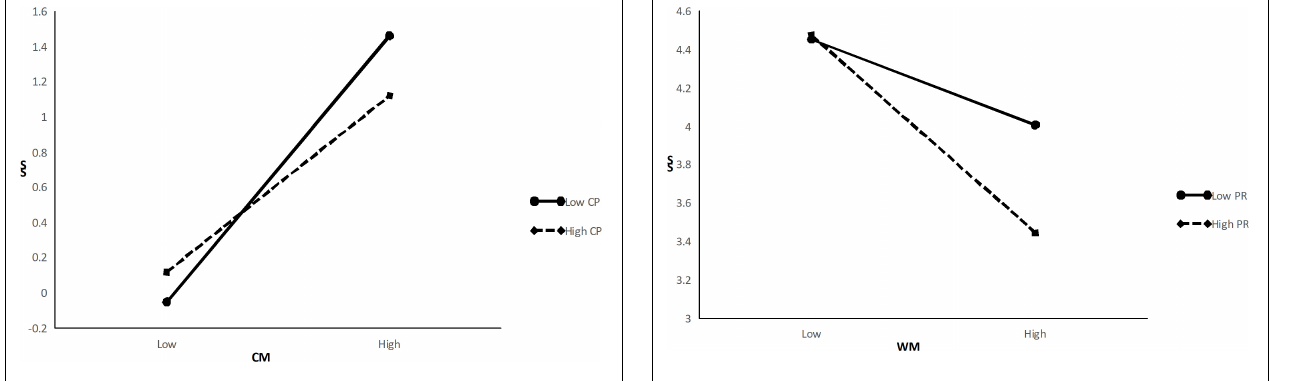
FIGURE 2 | Moderation effects of CP on the CM-SS relationship.